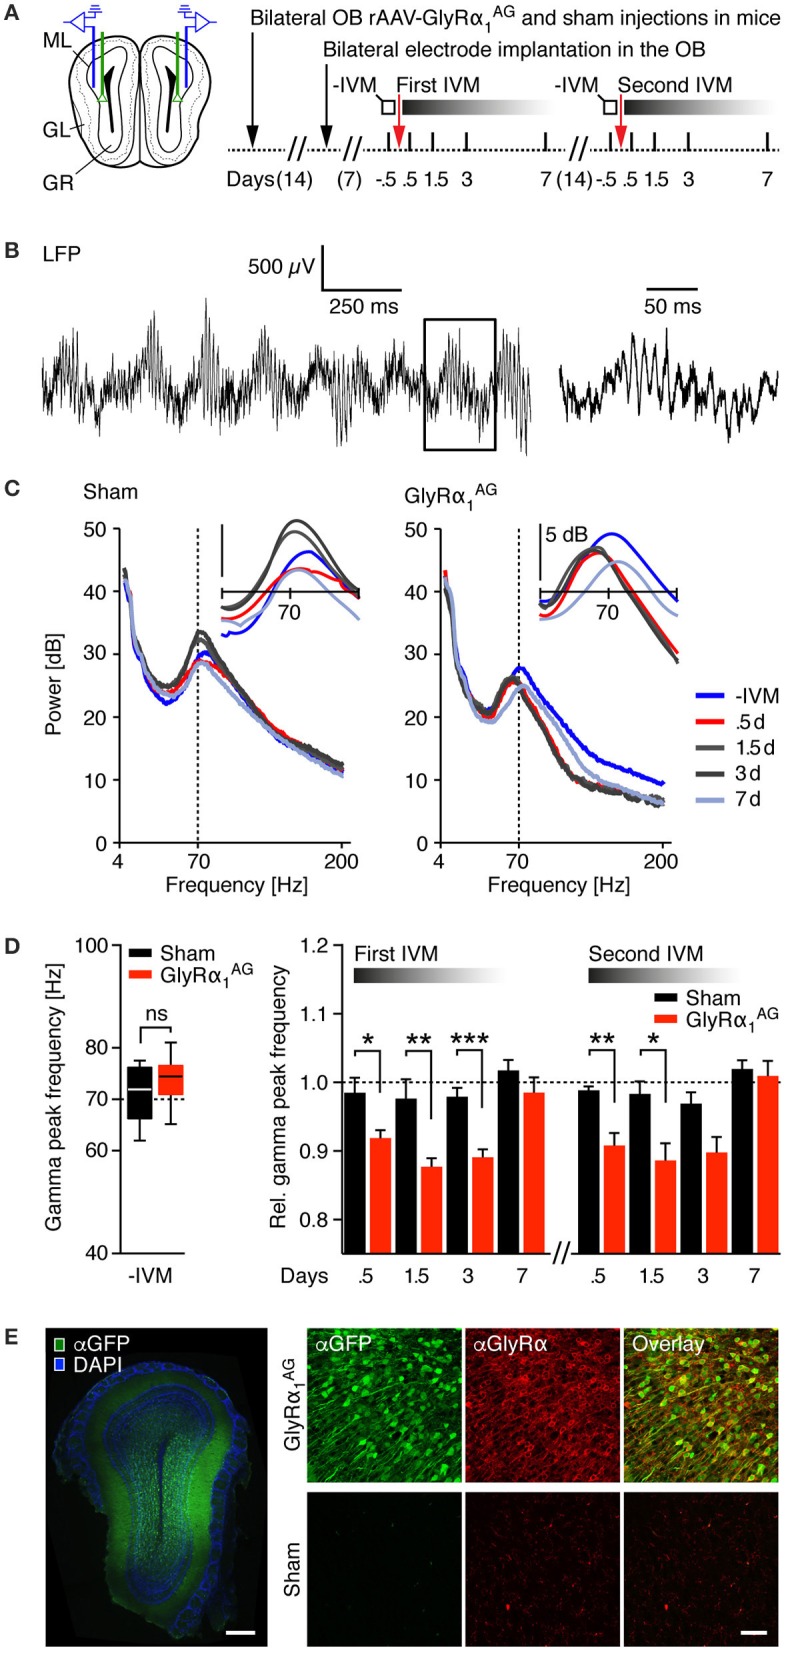
IVM induced shifts toward slower gamma oscillations in the olfactory bulb of mice expressing GlyRα1AG. (A) Left: Injection scheme; green lines indicate the path of the injection cannula for bilateral stereotactic rAAV-syn-GlyRα1AG-2A-Venus and sham (PBS) injections, and blue lines symbolize the position of the recording electrodes in the OB. Right: Time line of the experiment. Local field potentials (LFPs) were analyzed twice for 10 min in freely moving mice in an open arena on the days indicated. (B) Example raw signal of an intracranial LFP recording. Left: Fast oscillations overlying a slower rhythm are clearly visible. Right: Magnification of the box shown on the left shows fast oscillations in the gamma range. (C) Frequency analysis of LFPs (4–200 Hz) for one sham (left) and one GlyRα1AG expressing mouse (right) over 10 min recordings; colors indicate recordings on different days over the time course of 1 week; vertical dashed line at 70 Hz is shown for reference. Inset: smoothed frequency analysis in the 40–100 Hz range. (D) Left: Baseline gamma peak frequencies (pooled first and second IVM injection); ns, not significant (p > 0.05); median, 25th/75th percentile. Right: Relative gamma peak frequencies normalized to baseline during 1 week after IVM; a substantial shift in the relative gamma peak frequency was observable 0.5, 1.5, and 3 days after IVM treatment in the OBs of rAAV-syn-GlyRα1AG-2A-Venus but not sham injected mice. First IVM: GlyRα1AG
n = 4, sham n = 4 (1.5d: GlyRα1AG
n = 3, sham n = 2); second IVM: GlyRα1AG
n = 3, sham n = 2. Data shown as mean ± SEM; *p < 0.05; **p < 0.01; ***p < 0.001. (E) Left: Stereotactic injection of rAAV-syn-GlyRα1AG-2A-Venus into the OB yielded broad expression of Venus (αGFP, green) at the injection site; counterstained for DAPI (blue); scale bar: 250 μm. Right: Confocal imaging revealed over-expression of GlyRα1AG (αGlyRα, red) in Venus (αGFP, green) positive neurons; scale bar: 40 μm.